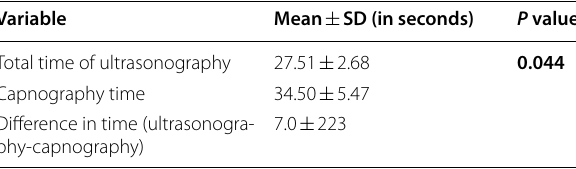
Data are presented as number (%). TUS Tracheal ultrasonography, SLS Sliding lung sign, DUS Diaphragm motion ultrasonography, AUC Area under the curve, NPV Negative predictive value, PPV Positive predictive value Table 7 Comparison of the mean time used to confirm the correct position of endotracheal tube ETT by ultrasonography and